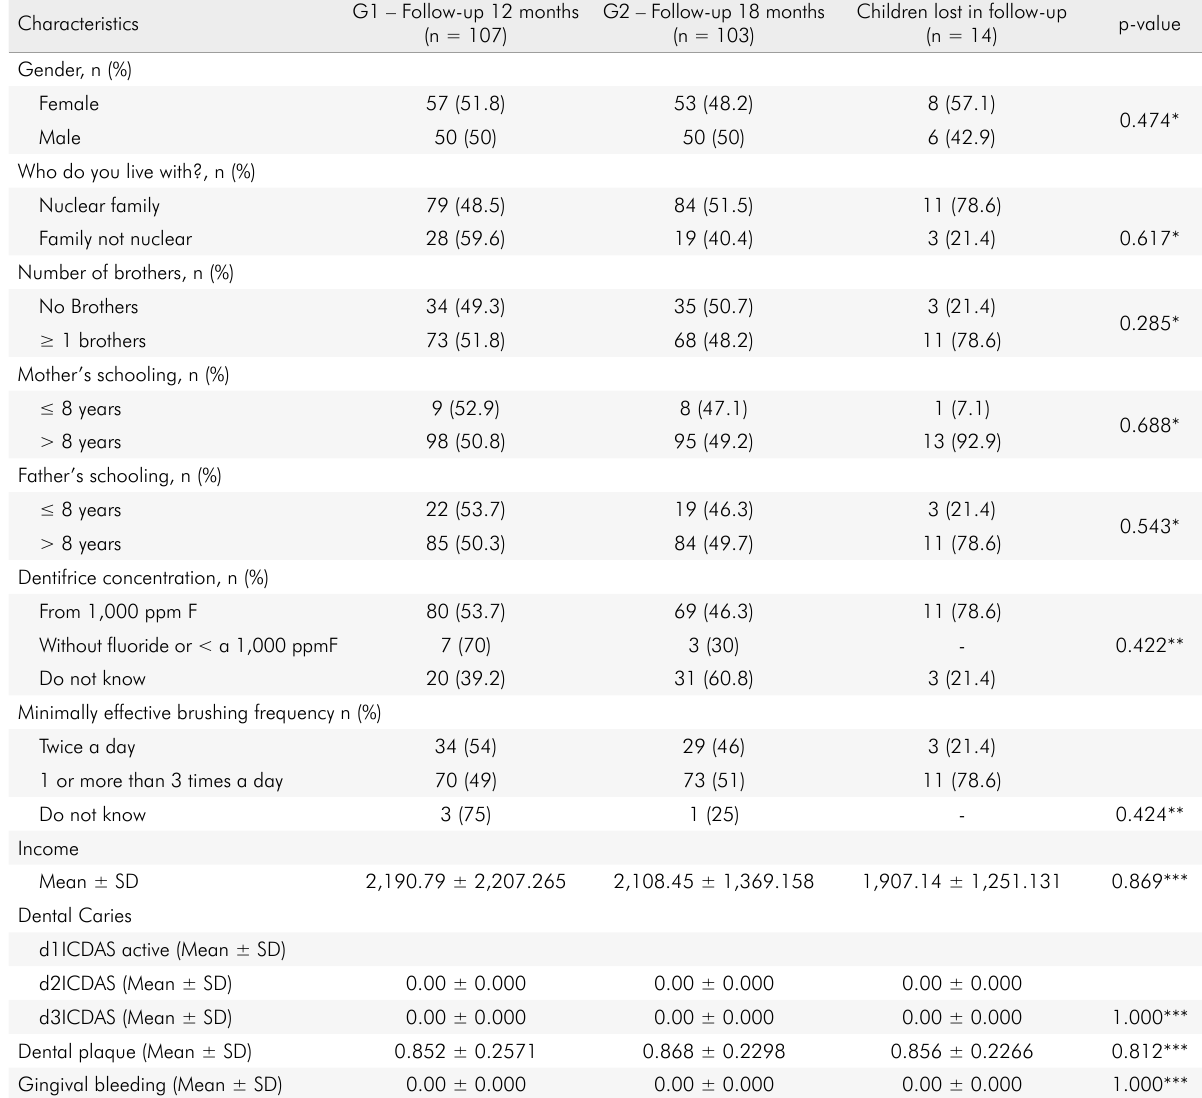
Table 2. Socioeconomic and clinical characteristics in the initial consultation of the children examined and of those who were lost during the follow-up